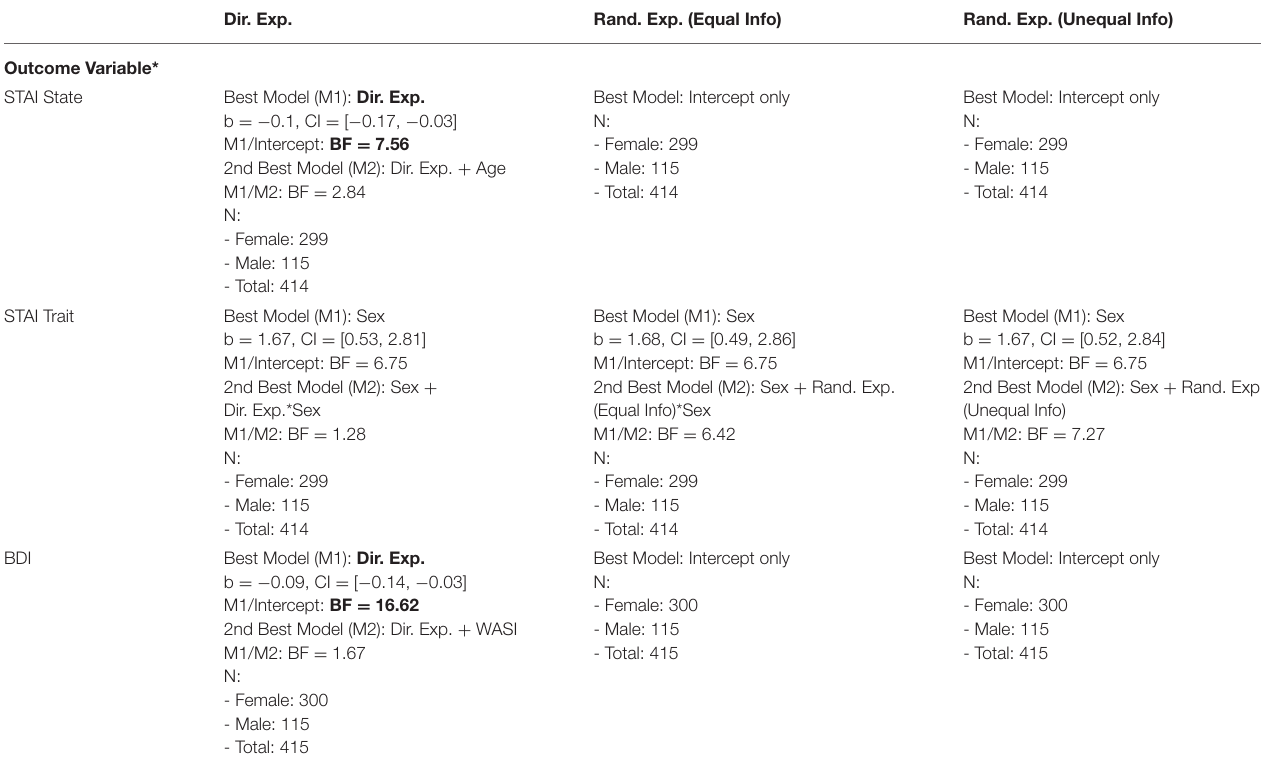
TABLE 3 | Exploration as a predictor of symptoms. Dir. Exp. Rand. Exp. (Equal